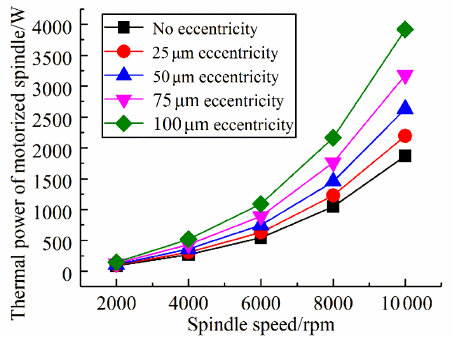
Figure 10. Thermal power of the motorized spindle under different eccentricities of each